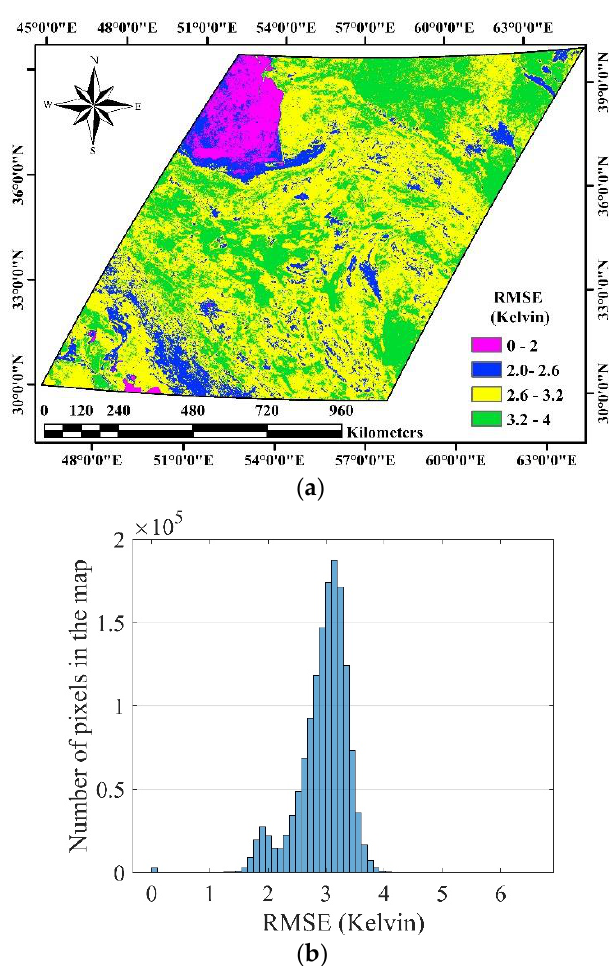
Figure 11. Root mean square error (RMSE) map between the original data and reconstructed data by SSA algorithm in an annual LST time series with 730 images ( a ) and histogram of the RMSE map ( b ).